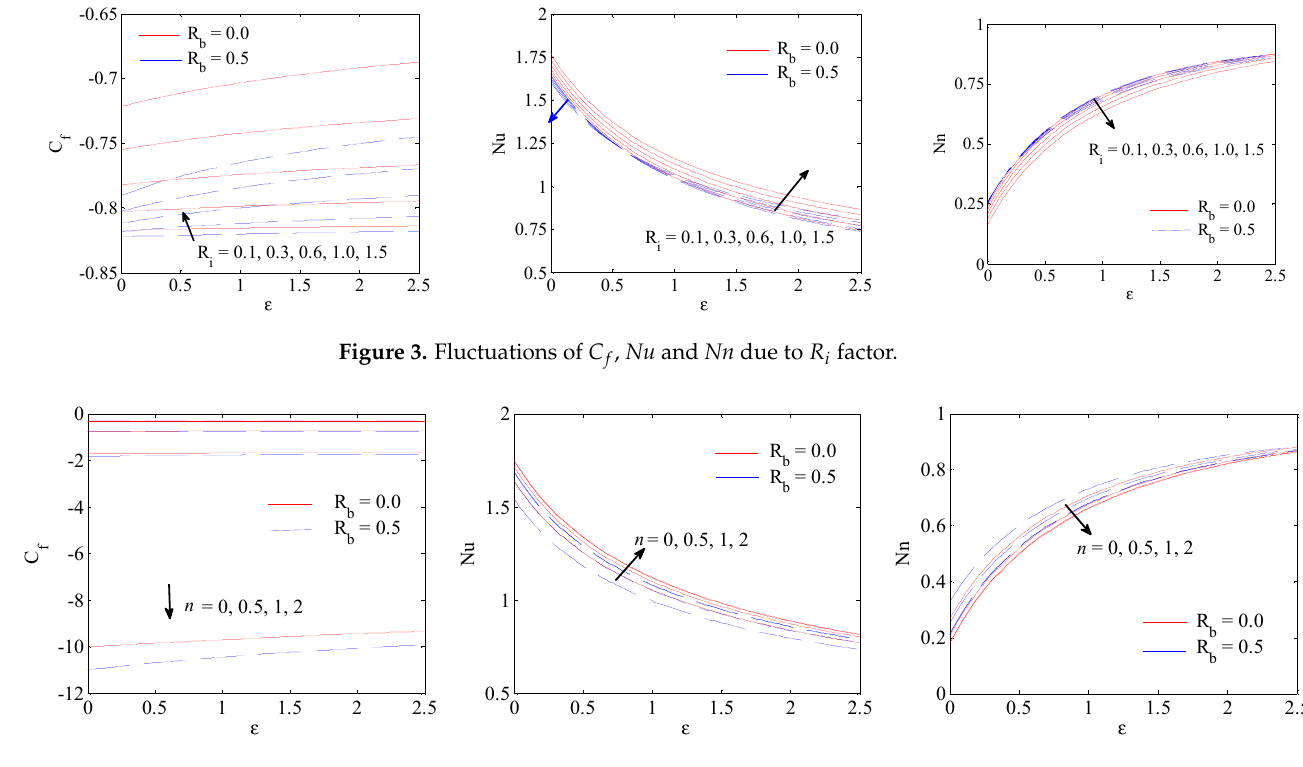
Figure 2. Fluctuations of C (cid:2916) , Nu and Nn due to W (cid:2915) factor.